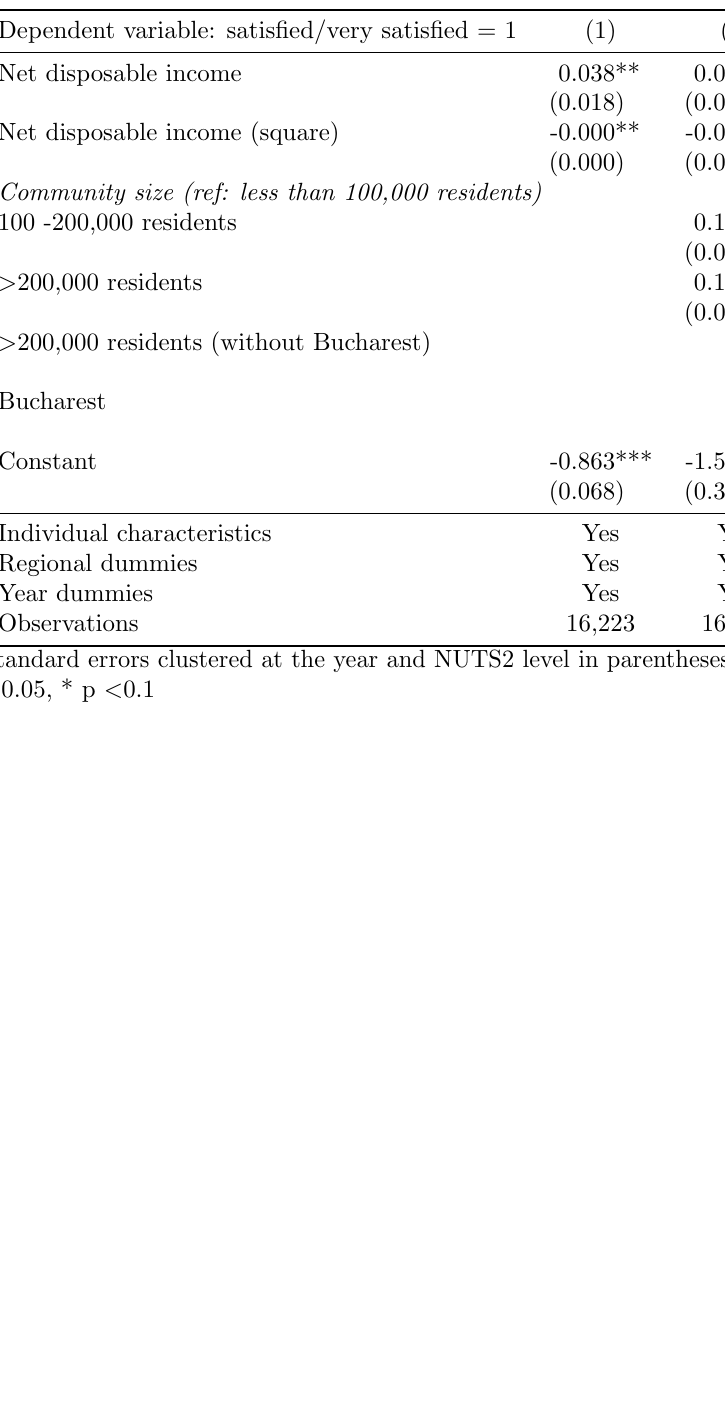
Table A.3: Life satisfaction and the role of regional income per